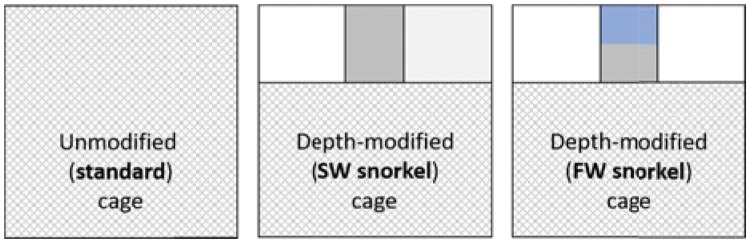
Schematic of an unmodified standard cage and depth-modified FW and SW snorkel cages. All cages were 12 × 12 m square and 12 m deep, although a 4 m deep net roof opening to a 3 × 3 m square and 4 m deep tarpaulin tube to the surface was fitted into snorkel cages (tarpaulin tube represented by grey shading). This restricted fish from accessing netted cage sections (cross-hatched) in the upper part of depth-modified cages. FW snorkels had a constant supply of freshwater added so a surface freshwater layer was created (solid blue shading).